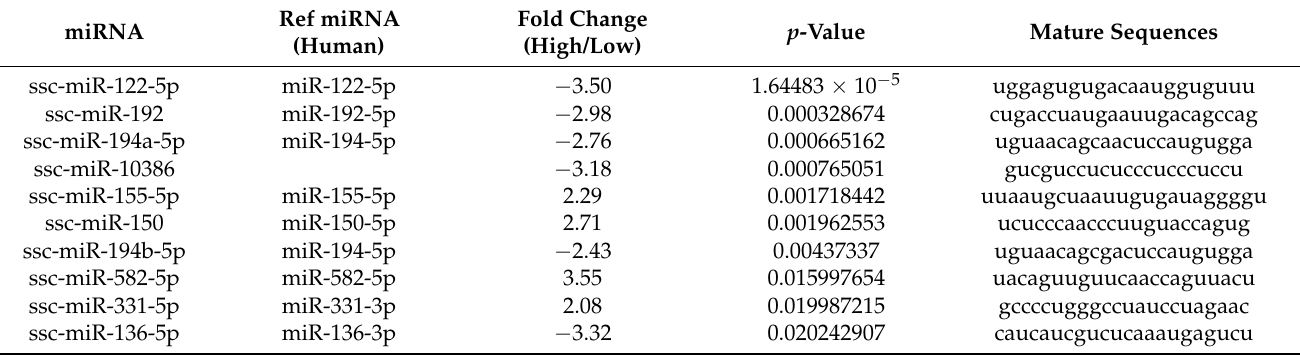
Figure 2. Volcano plot of DEMs in adipose tissues between high-FE and low-FE pigs. The blue dots represent the DEMs; the red dots represent the miRNAs with no significant expression differences. Table 3. A list of 14 differentially expressed miRNAs in adipose tissues between high-FE and low-FE pigs.